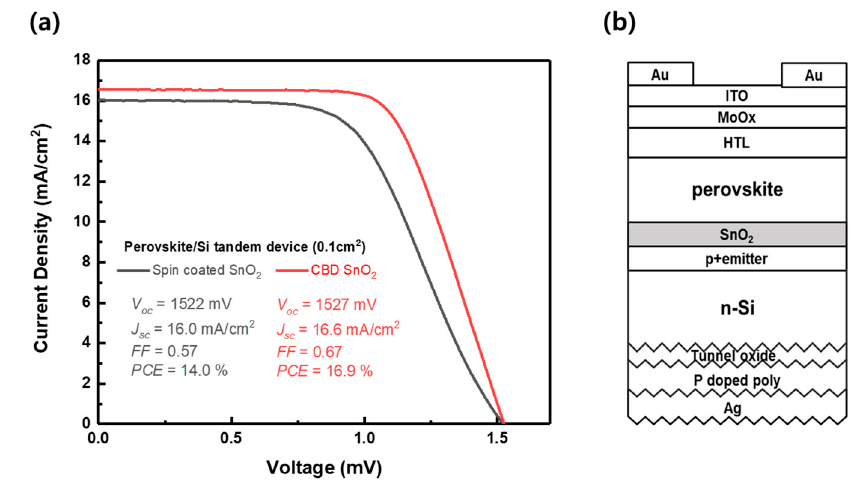
Figure 5. Monolithic perovskite/silicon solar cells with an active area of 0.1 cm 2 . ( a ) J-V curves of tandem cells using SnO 2 deposition by spin-coating and CBD. ( b ) Schematic of a perovskite/silicon tandem solar cell (not to scale).